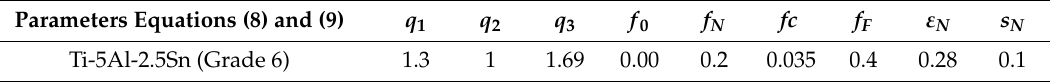
Table 2. Dimensionless parameters for the Gurson–Tvergaard (GTN) model for alpha titanium alloys. Parameters Equations (8) and